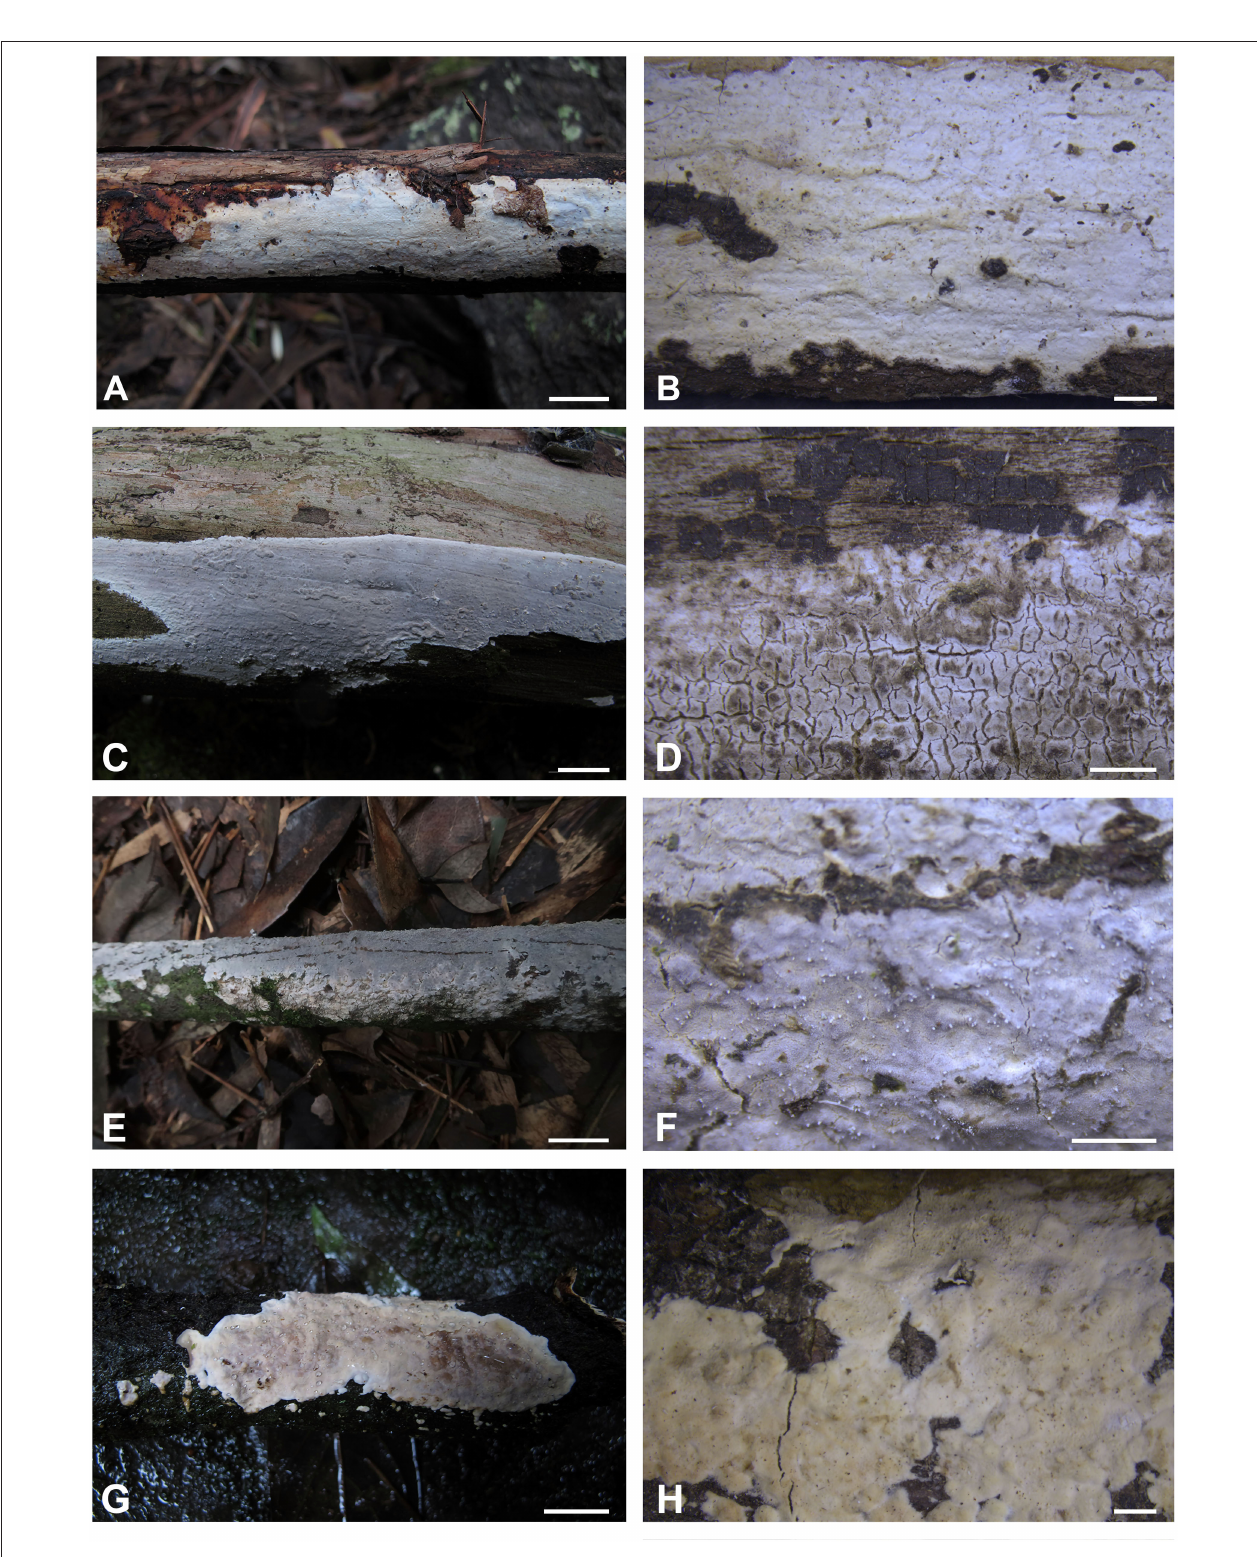
FIGURE 2 | Basidiomes of Alloexidiopsis . (A,B) A. australiensis (LWZ 20180513-22, holotype). (C,D) A. calcea (LWZ 20180904-24). (E,F) A. schistacea (LWZ 20200819-21a, holotype). (G,H) A. sp. (LWZ 20180920-16). Scale bars: (A,C,E,G) = 1 cm, (B,D,F,H) = 2 mm.